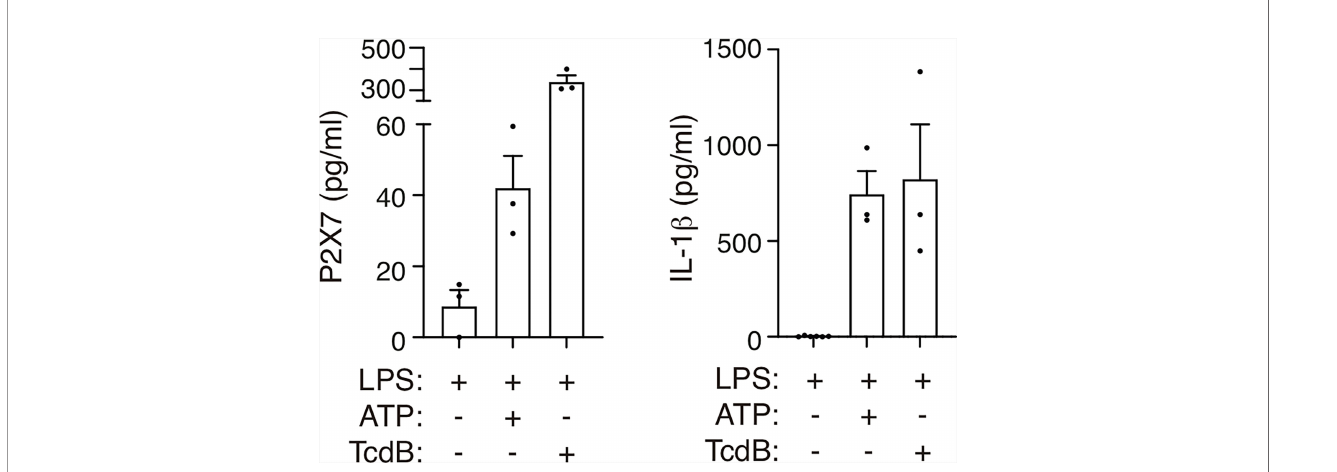
FIGURE 4 | Treatment with ATP or Clostridium dif fi cile toxin B induces the release of the P2X7 receptor. P2X7 receptor (left) or IL-1 b (right) from human peripheral blood mononuclear cells from healthy individuals treated for 3 h with LPS (1.6 m g/ml) and then treated with ATP (5 mM) for 45 min or with Clostridium dif fi cile toxin B (TcdB, 1 m g/ml) for 1 h. Each dot represents data from an independent